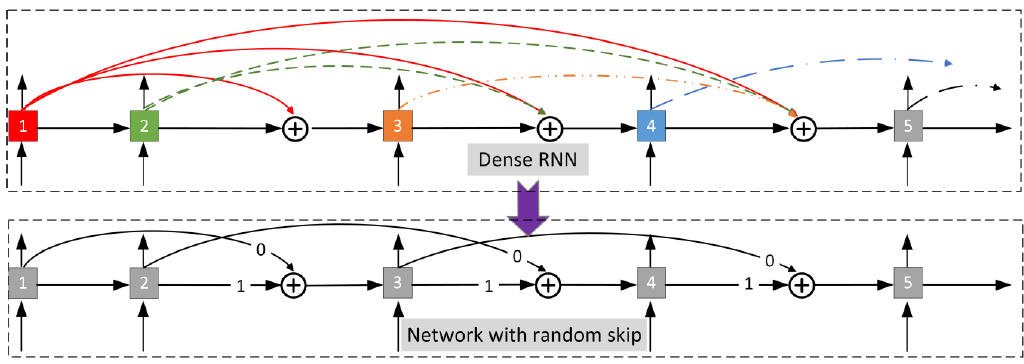
Figure 1. The framework of our proposed model. RNN: Recurrent neural network.